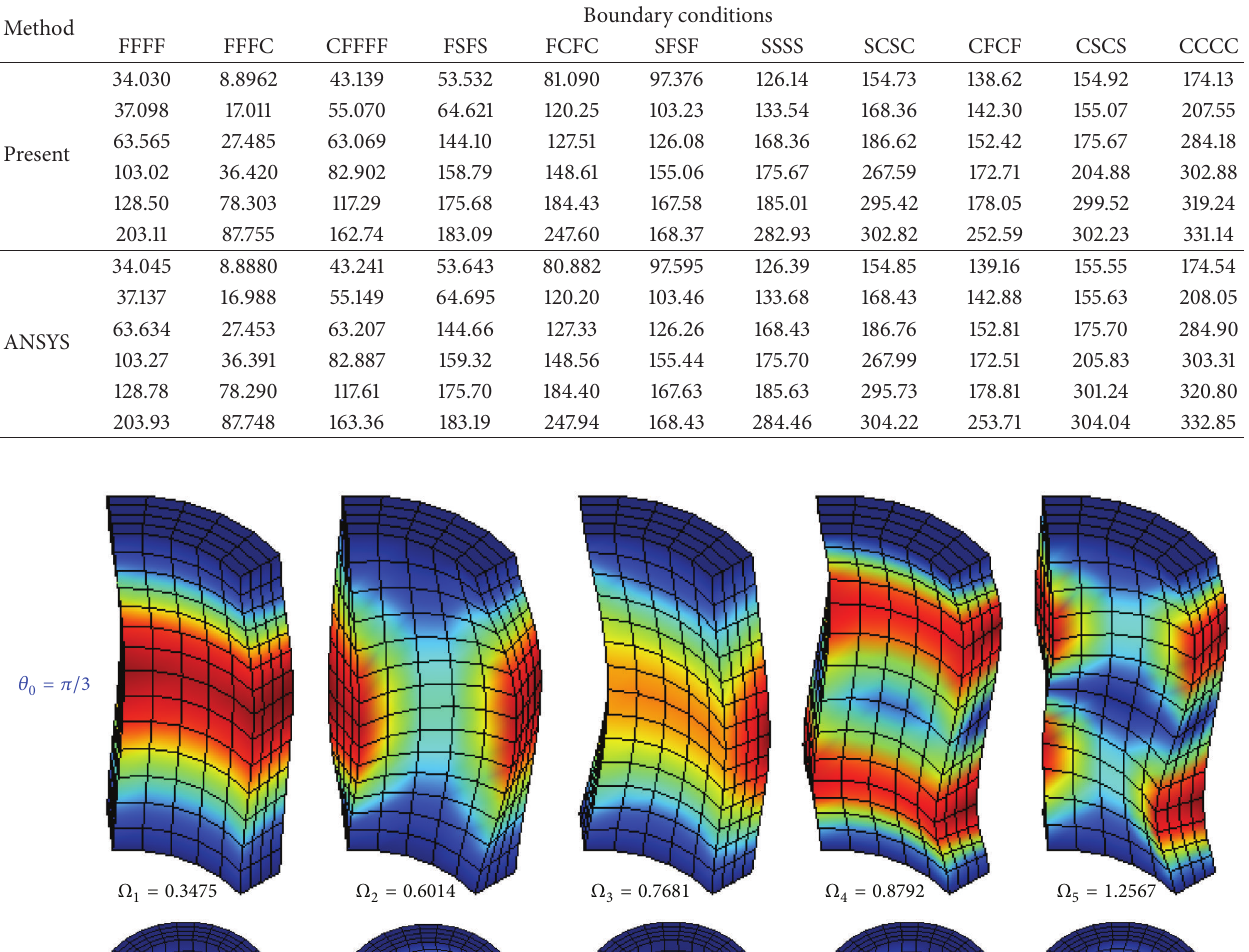
Table 8: Comparison of frequencies (Hz) of an open orthotropic cylindrical shell with different boundary conditions ( 𝐿 = 1 m, 𝐿/𝑅 = 3 , = 𝜋 ). ℎ/𝑅 = 0.3 , and 𝜃 0